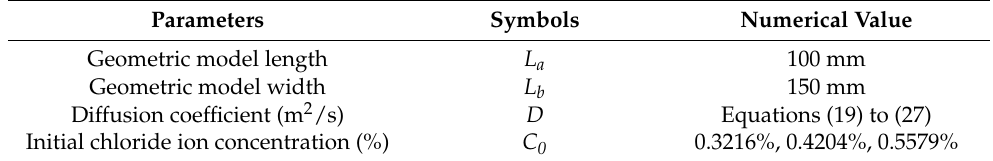
Table 11. Model parameter